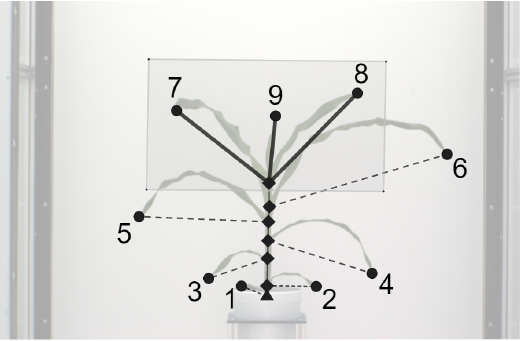
Figure 3. Illustration of leaf labeling in the case of a junction containing more than two leaves.